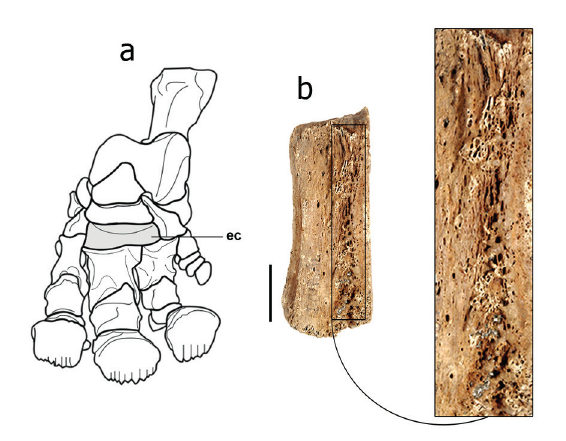
Figure 2 - ( a ) scheme of the foot of Panochthus sp. (modified from Burmeister, 1874); ( b ) left metatarsal III (MN 3631-V) in dorsal view with highlight of the lesion; ( c ) left metatarsal III (MN 3631-V) in lateral view with highlight of the lesion; ( d ) proximal articulation of left metatarsal III (MN 3631-V) with highlight of the lesion. Scale bar = 2.0 cm. Abbreviation: mt III: metatarsal III.